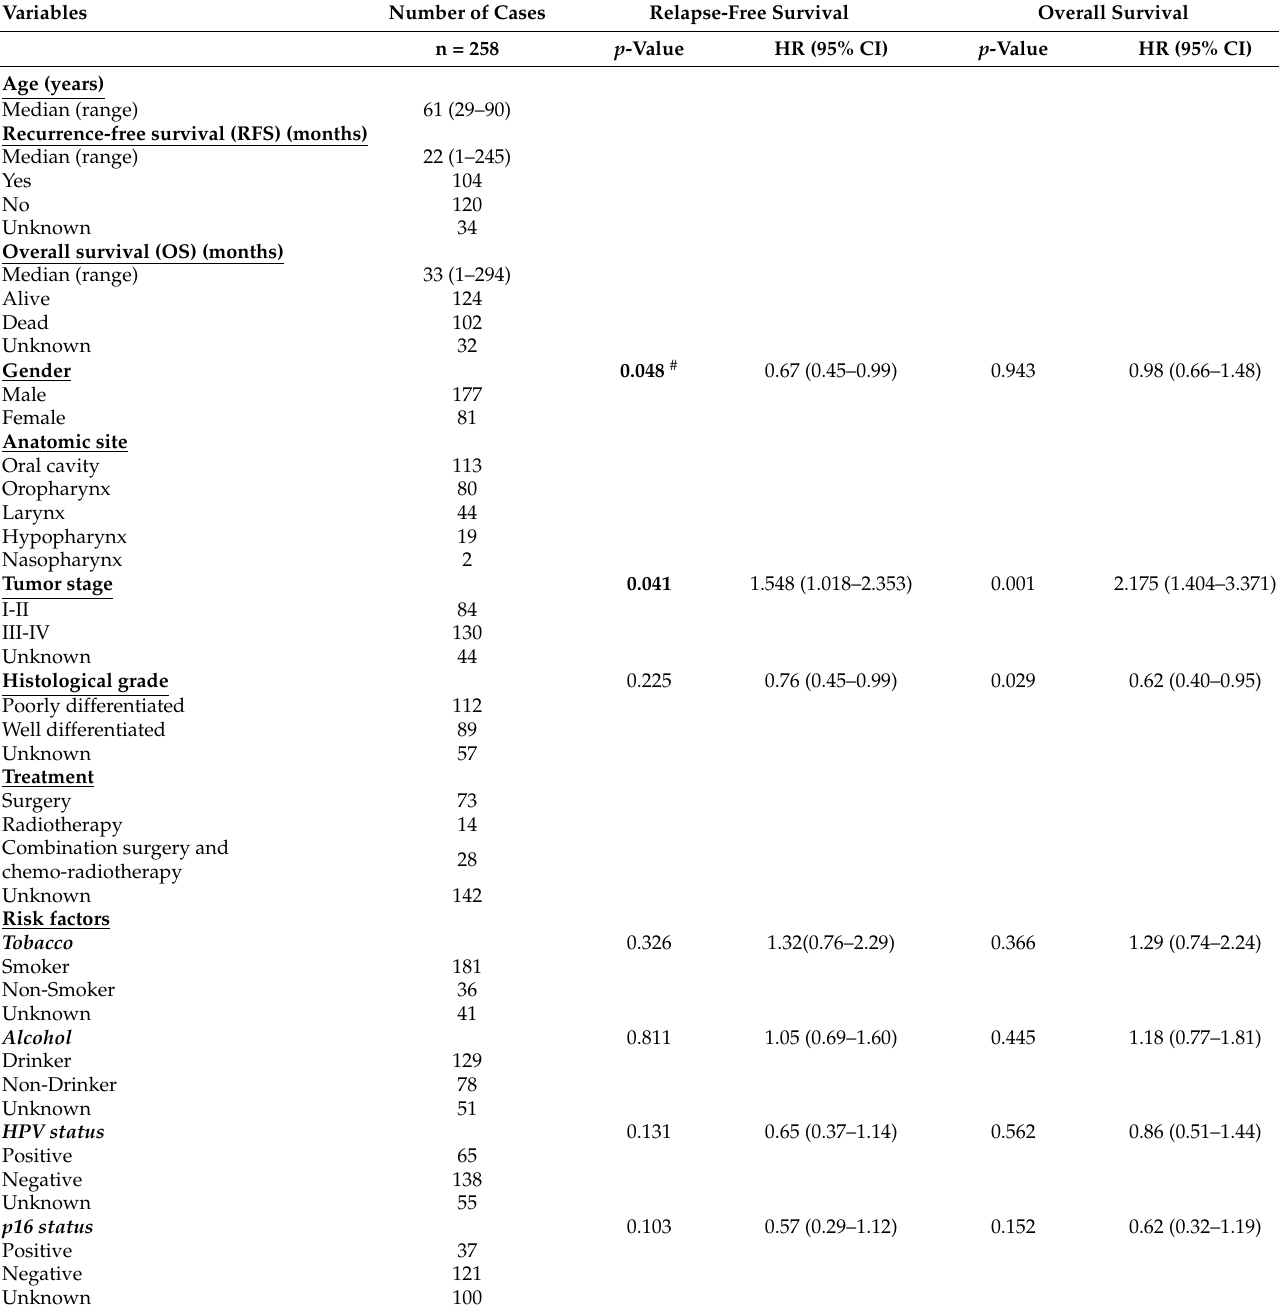
Table 1. Patient population